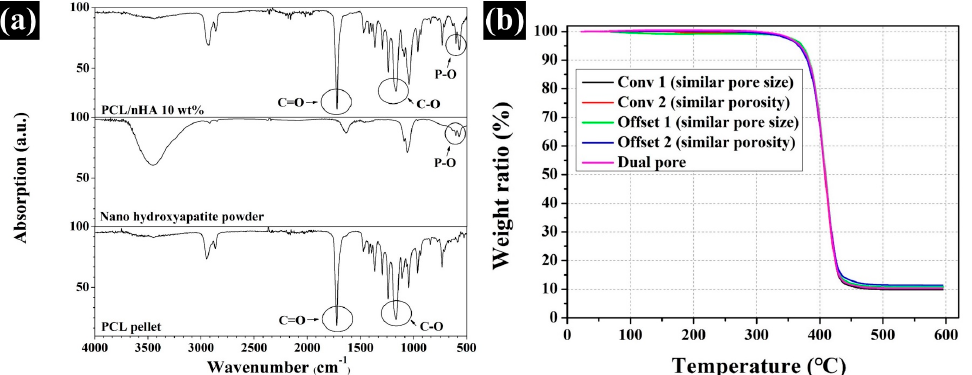
Figure 2. Comparison of the chemical composition and weight ratio: ( a ) FT-IR results for pure and PCL/nHA composite materials; ( b ) TGA results for the fabricated scaffolds.